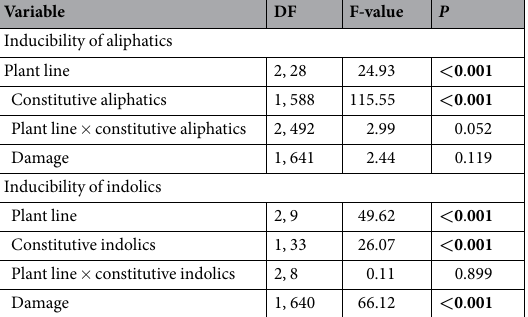
Constitutive concentrations of glucosinolates in leaves of B . olereacea were consistently lower in domesticated lines than in wild cabbage. These findings are in agreement with previous studies reporting reduced defences in domesticated crops relative to their wild relatives 17,18,20,30 . Two mechanisms have been proposed to explain this pattern. First, domestication may directly select for lower concentrations of compounds that are toxic, distasteful